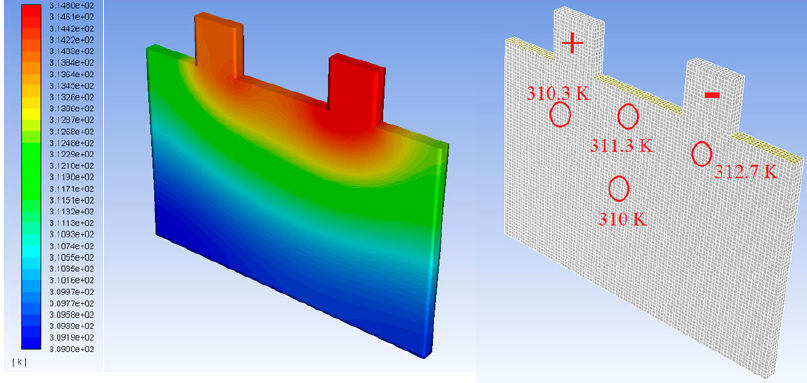
Figure 13. temperature distribution and experimental results at the end of 52 A discharge.